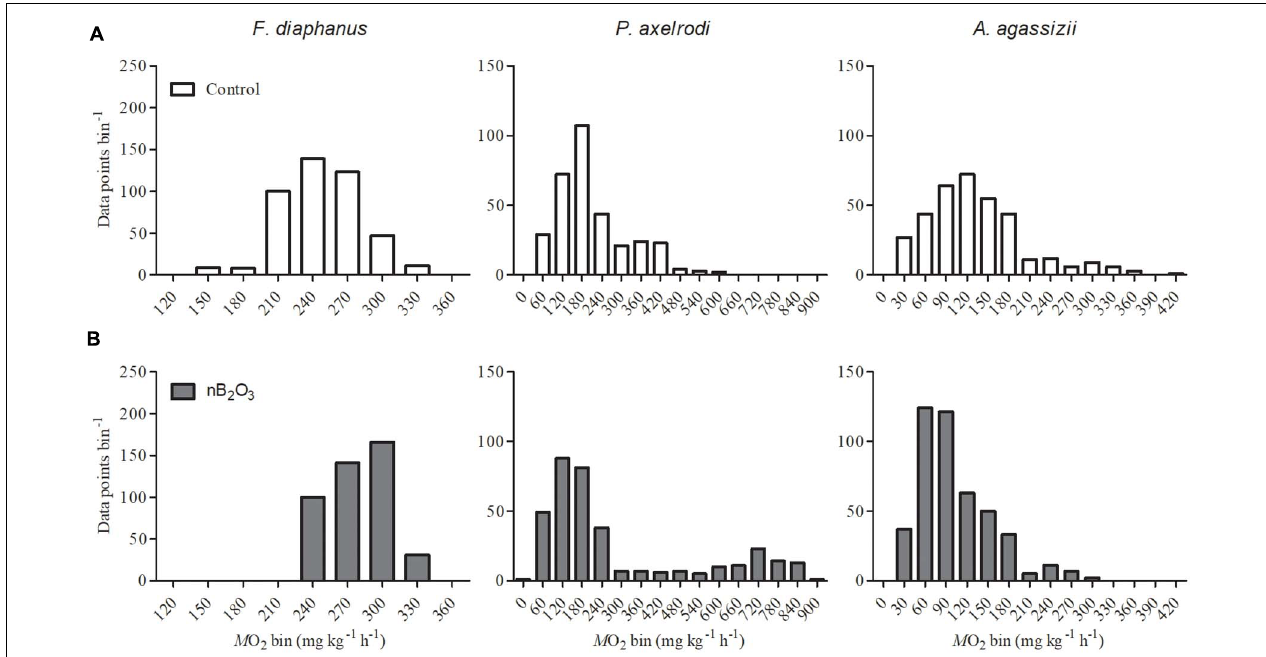
FIGURE 4 | Frequency distributions of whole animal ˙MO 2 recordings ( n = 6–9, as specified in Figure 3 ) were used as a proxy for spontaneous aerobic activity in Fundulus diaphanus, Paracheirodon axelrodi , and Apistogramma agassizii exposed to control conditions (A) or to nB 2 O 3 ( B ; 1.0 mg L − 1 for F. diaphanus and 10 mg L − 1 for P. axelrodi and A. agassizii ). Data were collected from undisturbed fish over the final 5 h of each ˙MO 2 recording.